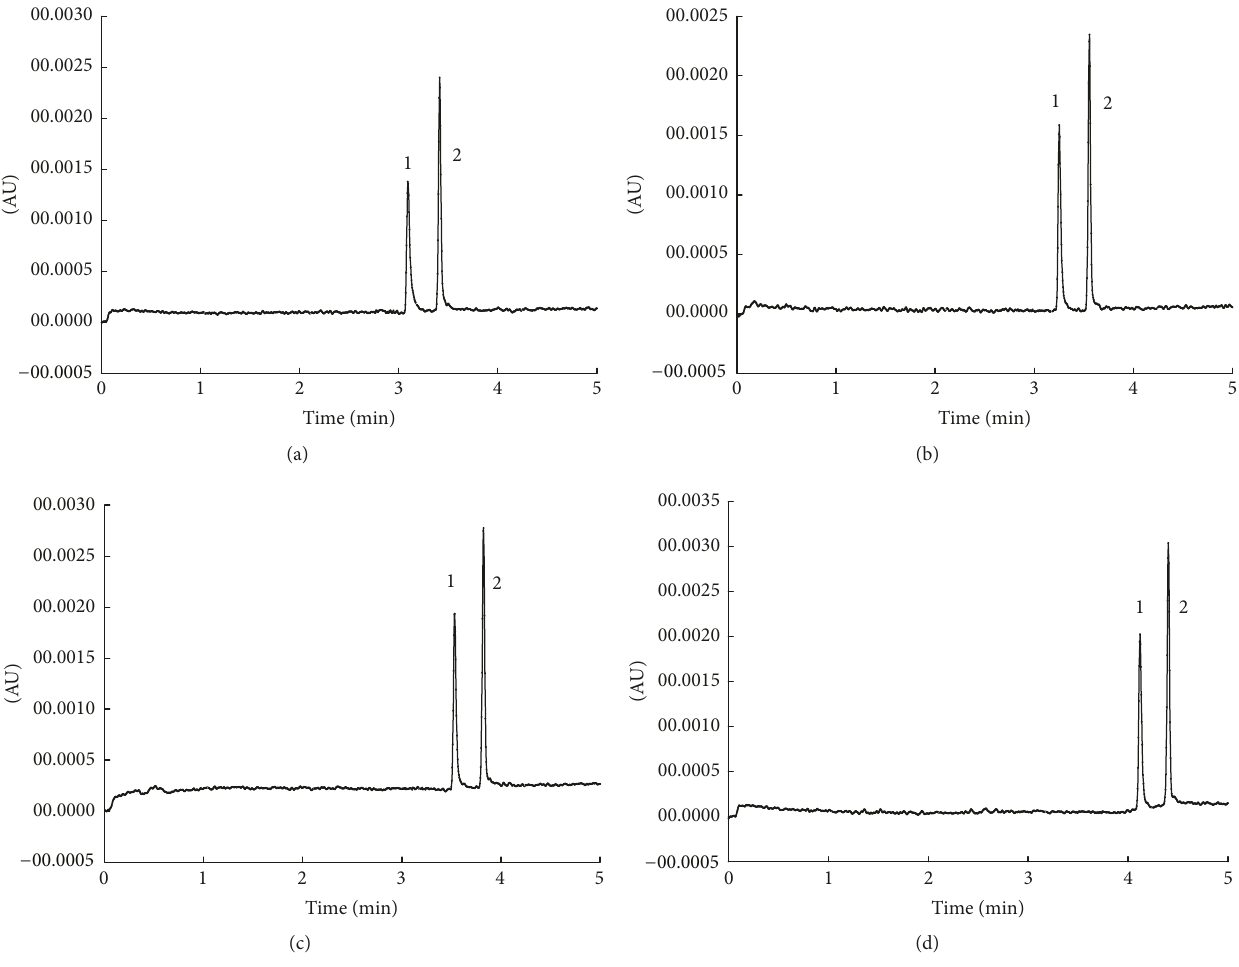
Figure 2: Effect of the different pH on the separation. Separation conditions: running buffer, 35 mmol/L H 3 BO 3 -Na 2 B 4 O 7 ; separate voltage, 25 kV; operating temperature, 22 ∘ C; the detection wavelength, 275 nm; injection, 0.5 psi, 4 s. Chromatogram identification: (a) 8.6; (b) 8.8; (c) 9.0; (d) 9.2. Peak identification: 1: sarafloxacin; 2: